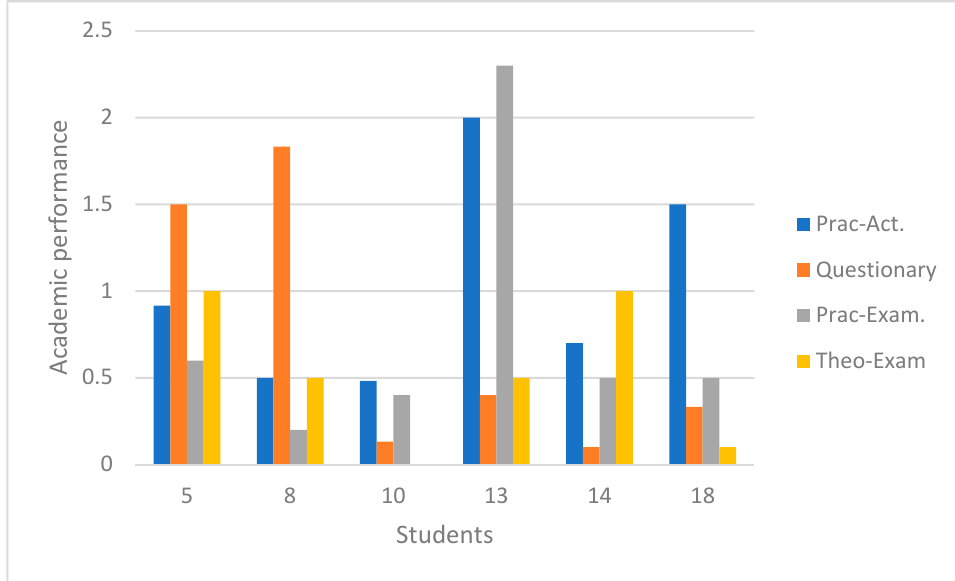
Figure 7. Student performance according to the evaluated activities.